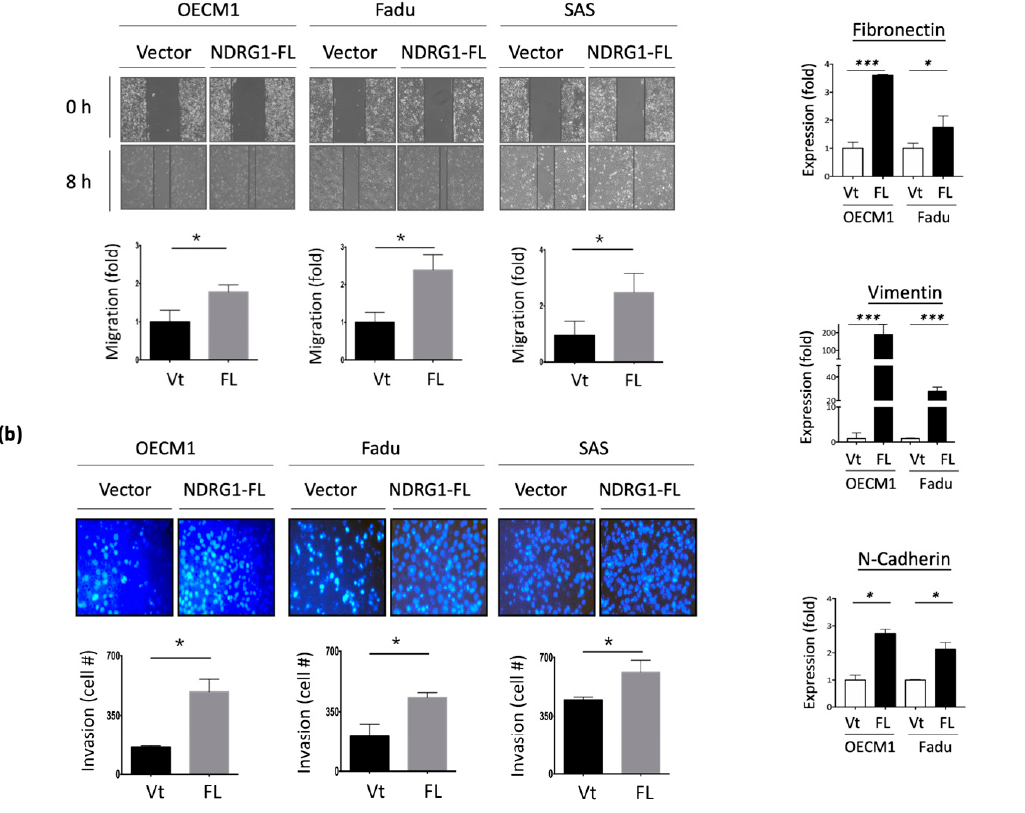
Figure 3. NDRG1 promoted cell motility via ECM mechanism. ( a ) NDRG1 facilitated cell migration in HNC cells. After seeding the NDRG1 overexpression (FL) or vector control (Vt) transfected cells into ibidi culture inserts for 8 h, cells were subjected to wound healing migration analysis. ( b ) NDRG1 increased cell invasion in HNC cells. After seeding the NDRG1 overexpression (FL) or vector control (Vt) transfected cells into Matrigel-coated membranes for 30 h, the cells were subjected to a Matrigel invasion assay. ( c , d ) OECM1 and FaDu cells were transfected with NDRG1- FL or vector control and cells were collected for RT-qPCR analysis ( c ) or the cellular proteins were extracted and subjected to Western blot analysis and determination of protein expressions by antibodies ( d ). The GAPDH was used as an internal control. All the experiments were performed three times independently and typical results were shown. The error bars shown in the relevant figures indicate the standard deviation of the quantification results in all experiments. (* p < 0.05; ** p < 0.01; *** p < 0.001; t -test).